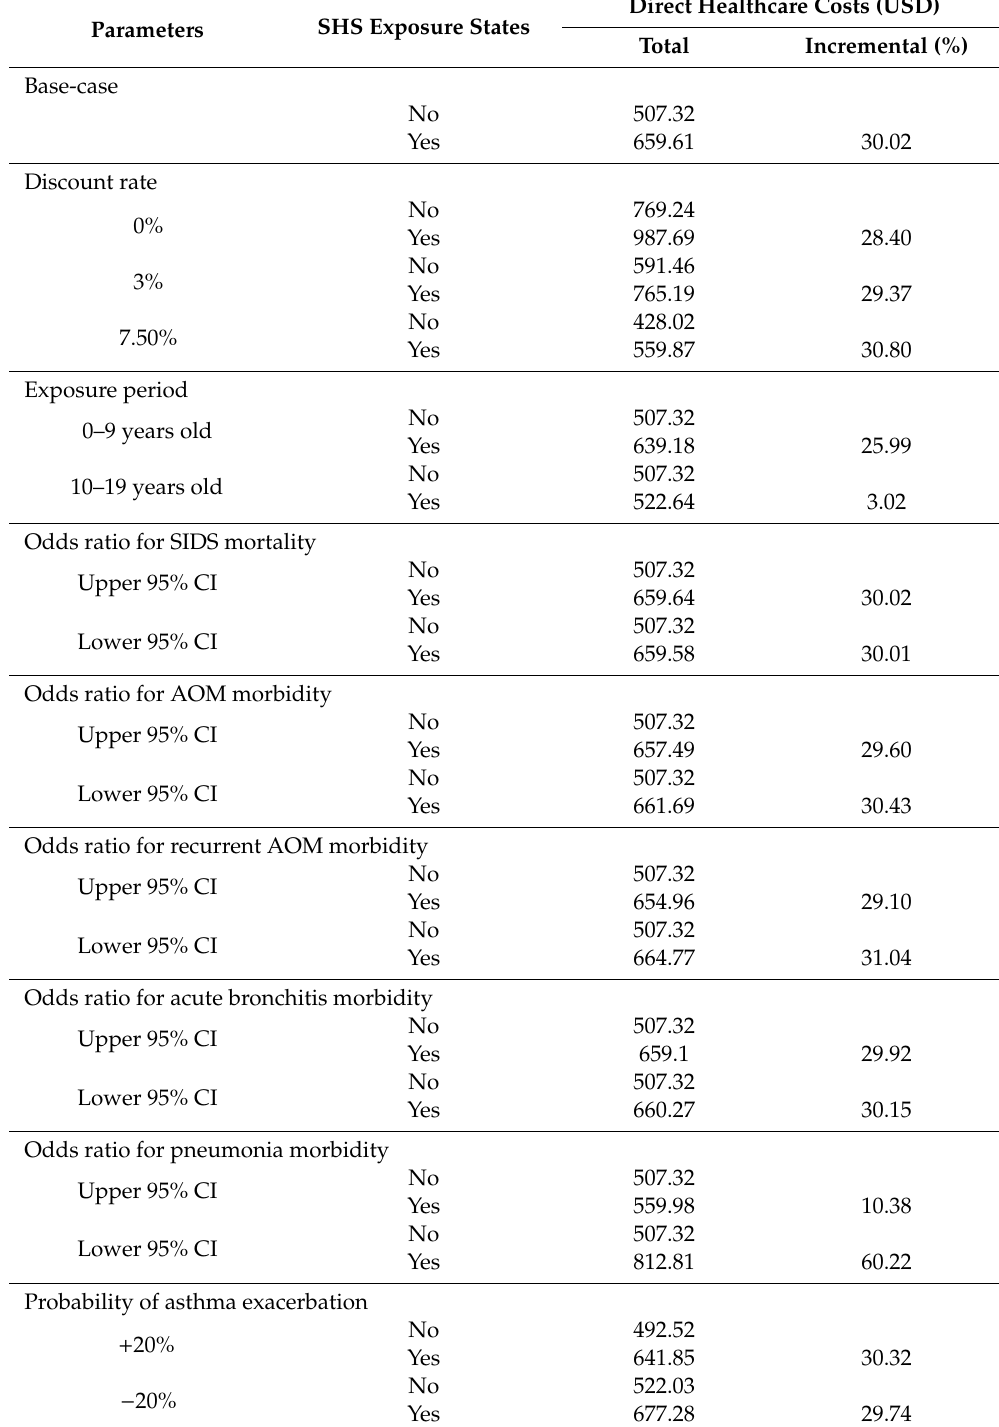
Table 4. Base-case and one-way sensitivity analysis results for Korean children who were exposed to SHS in the home compared with nonexposed